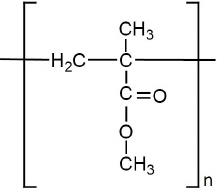
Figure 2. Molecular structure of polymethyl methacrylate. It is a hydrocarbon chain with CH ₃ and COOCH ₃ groups at the sides.